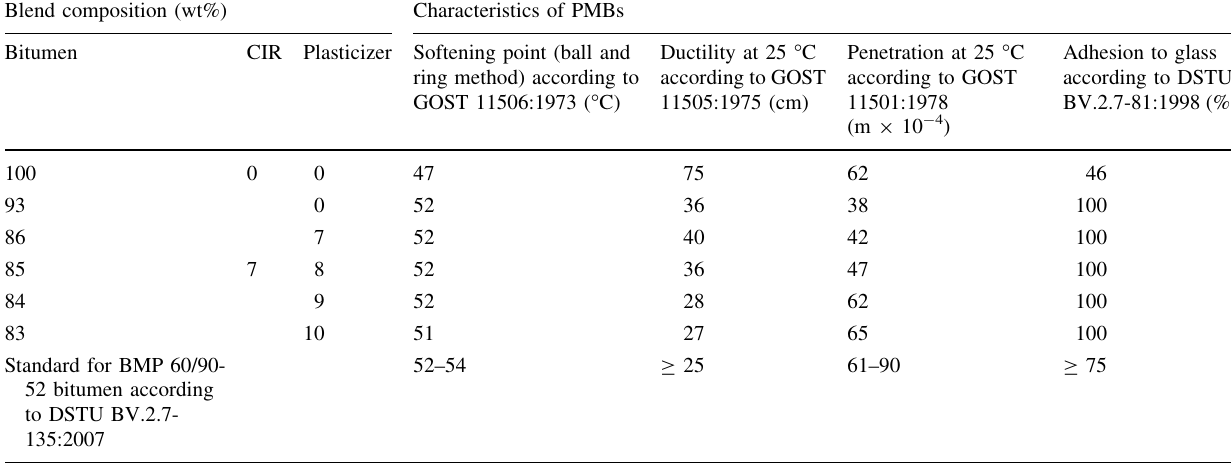
DSTU and GOST refer to Ukrainian national standards Table 11 Gases composition of desulphurized lignite Component Water vapour in the oxidant